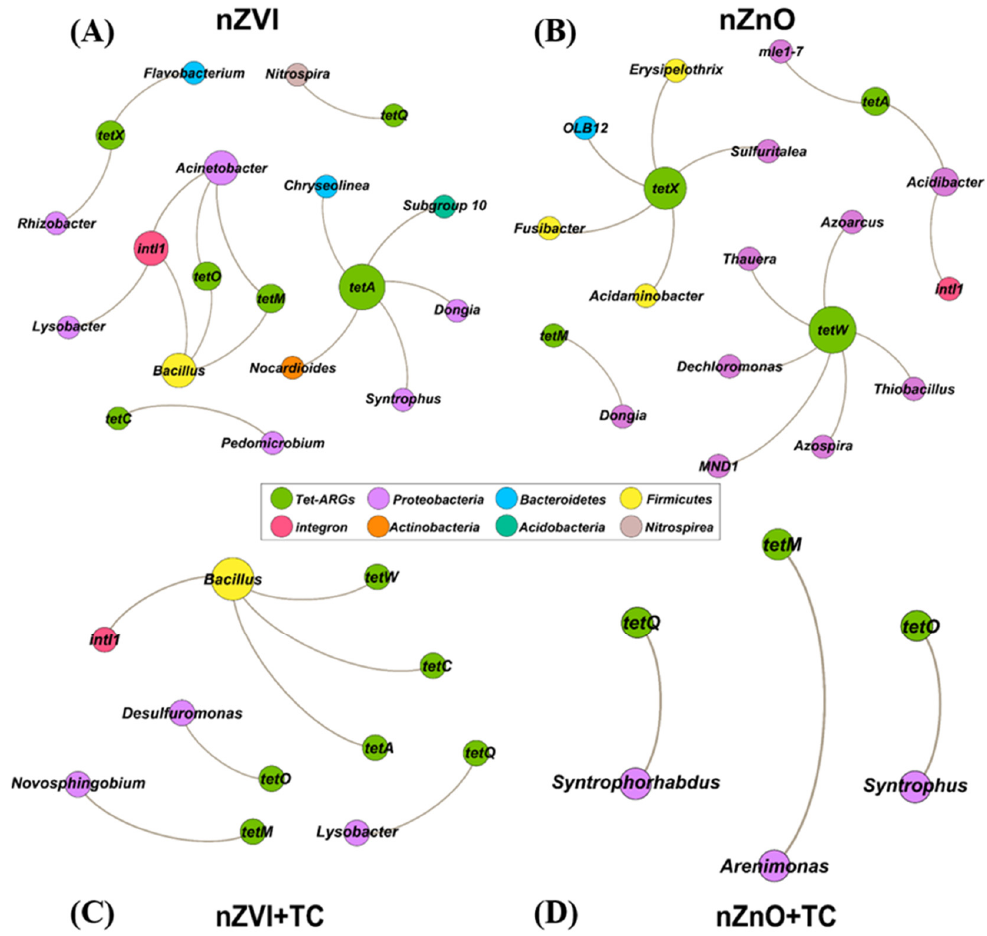
Figure 5. Network analysis between bacterial genera and tet -ARG/ intI1 in ( A ) nZVI, ( B ) nZnO, ( C ) nZVI+TC, and ( D ) nZnO+TC sediment. TC means sediment overlaid with 10 mg L − 1 tetracycline solution.